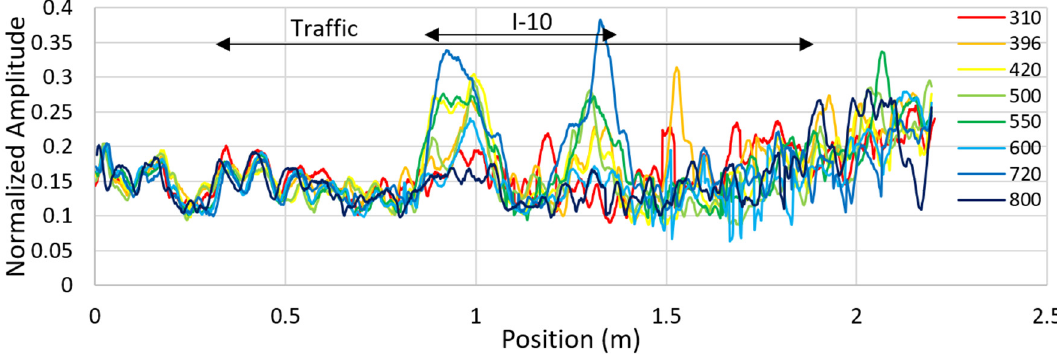
Figure 38. 2.6 GHz Normalized RW amplitudes on defect I-10, in the transversal direction vs. K loadings. Defects I-4, I-9, and I-10, located on the center of the traffic zone, present amplitude values roughly two times lower than the value obtained from defect I-12, with some punc- tual zones in which amplitude values exceed just the average of neighboring healthy ar- eas. These strong variations of EM contrasts suggest variation of tack coat gluing, induc- ing possible water ingress. Most surprising is the shape of I-10 results (Figure 38) showing detection only on the borders of the defect. Amplitudes are growing vs. traffic during the summer 2019 (from 310 K to 550 K loadings) and a slow decrease at 600 K loading step. For these last meas- urements, the explanation could come from the fact that the heavy traffic, going towards 600 K loadings, was realized several weeks before GPR measurements, letting the struc- ture auto-repair with the high temperatures. We find a similar situation for the 800 K load- ing step: Low radar amplitudes, measurements done at the end of May, and traffic cycles done numerous weeks before. The exception comes from the 720 K loading steps, as GPR measurements were performed in winter (January 2020) during a cold and rainy period, and showing strong EM contrasts may be due to water ingress. This analysis, done on defect I-10, is representative of almost other defects. Concerning transversal profiles, we can see the combined effects of lateral traffic den- sity (see Figure 32) and topography (see Figure 35), which can induce inward water mi- gration, on the GPR amplitude. 4. Autopsy of the Road Section 4.1. Extraction of Transversal Blocks At the end of the loading series and GPR experiments, several trench cores were sam- pled to get a ground truth of the damaged structure, and first of all, the real thickness of the defects and their lateral length. Six trenches have been realized in the area of the larg- est defects. Four transverse trenches were located at the center of defects I-10, I-11, I-12, and I-13, at the level of the GPR profiles, and dimensions of approximately as follows: 1.30 x 0.25 x 0.15 m (Figure 39). One transverse trench was done between defects I-11 and I-12 to obtain information of the traffic effect on a healthy zone. The last one was sawn longi- tudinally from the center of I-12 towards I-13, 1.2 m long.